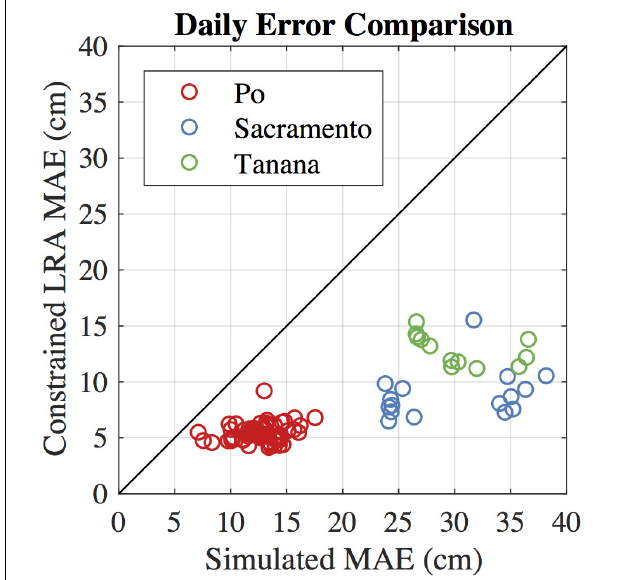
FIGURE 5 | MAE before and after the CLRA method for each observed profile. Points below the 1:1 line indicate the CLRA method decreased the height errors.